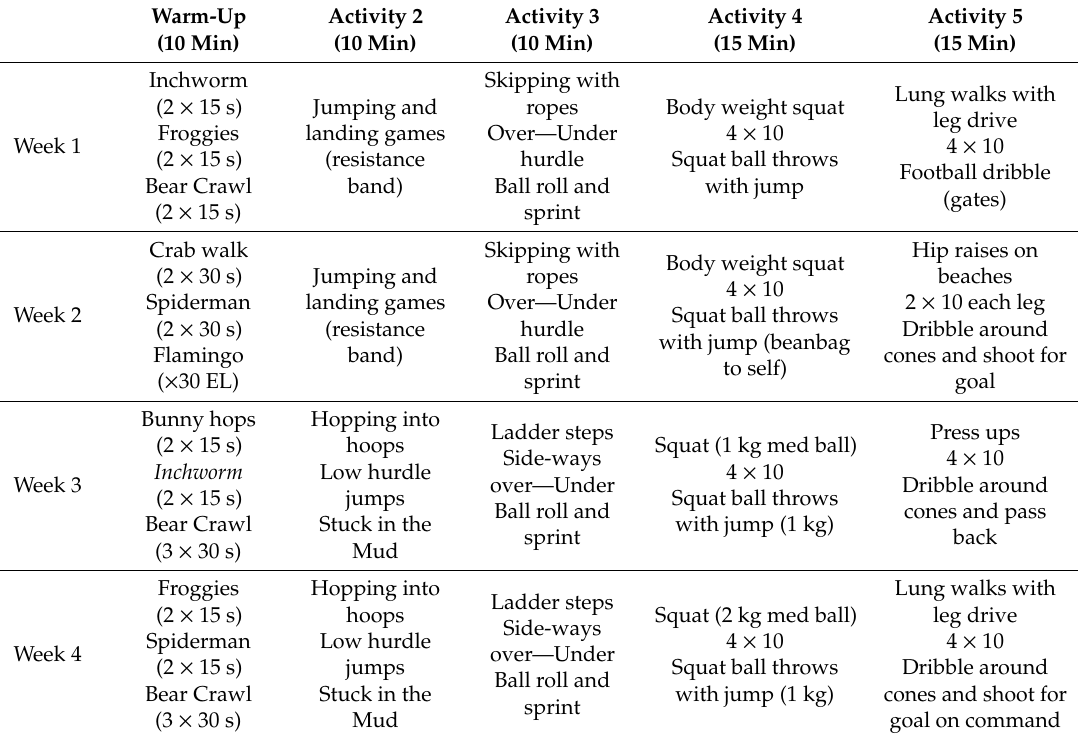
Table 3. Fundamental movement skill and strength training